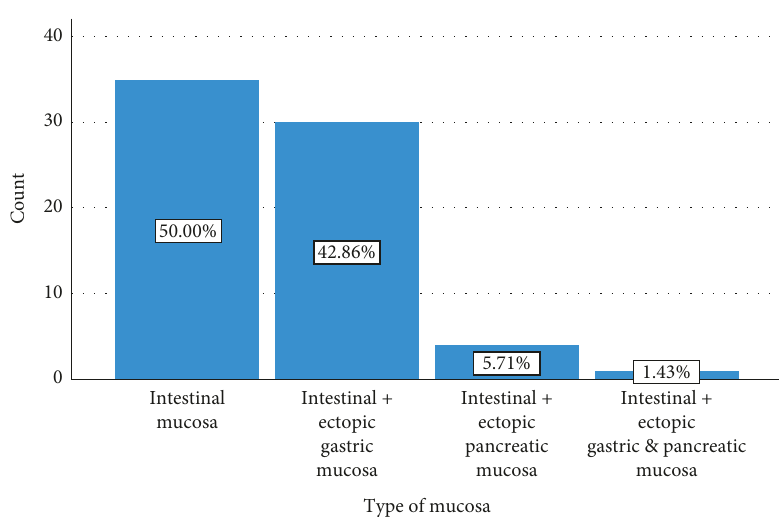
Figure 2: A simple bar chart showing the types of the mucosal linings of the Meckel’s diverticulum.